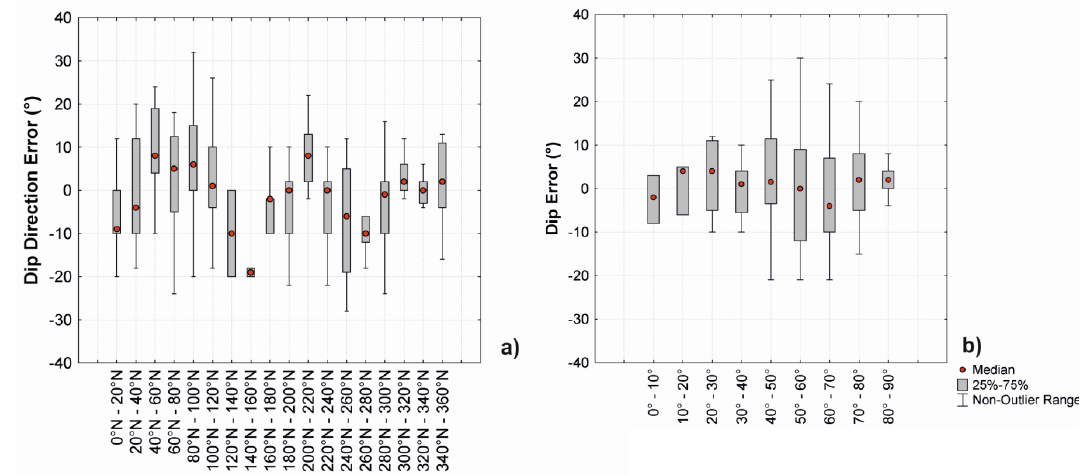
Fig. 5. Box plots of errors on dip direction (a) and dip (b) of 191 geostructural data identified in two accessible test areas (Fig. 2).